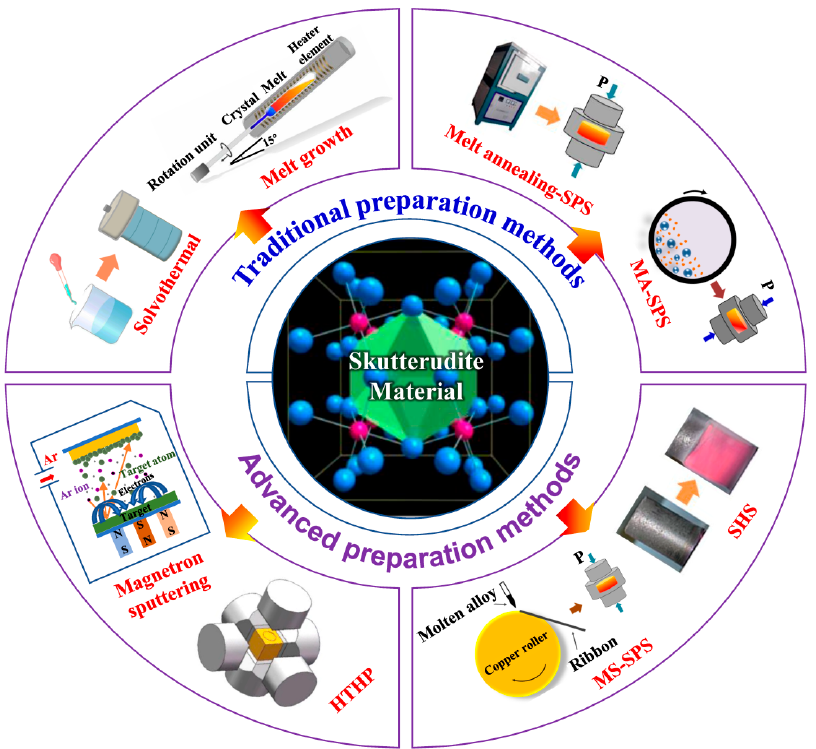
Figure 1. Schematic diagram of some preparation methods for skutterudite materials [27,28]. (MA: mechanical alloying; MS: melt spinning; SHS: self-propagating high-temperature synthesis; HTHP: high temperature and high pressure; SPS: spark plasma sintering).